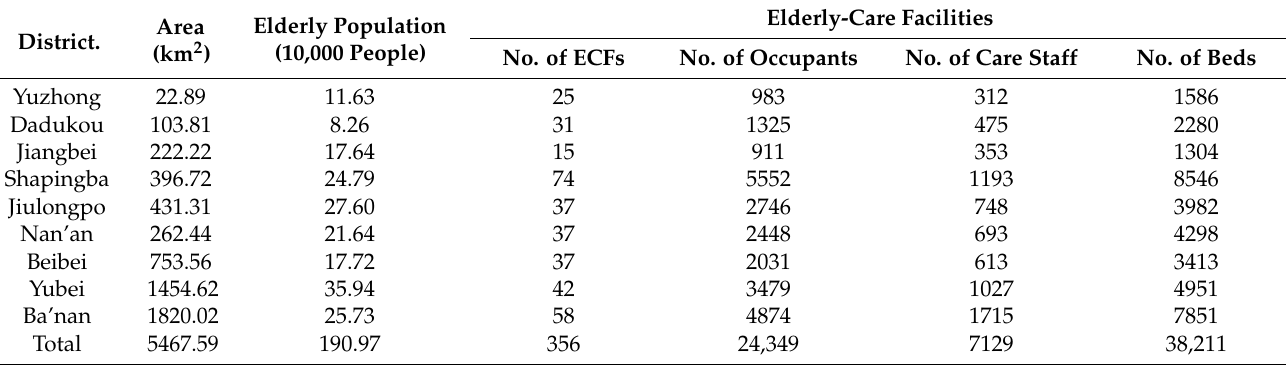
Table 1. EFCs of Different Districts.